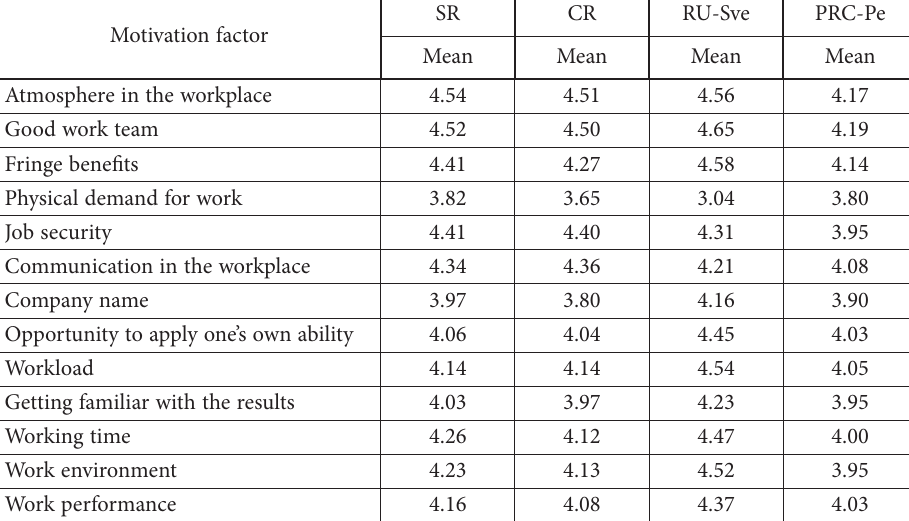
Table 2. Average values of analysed motivation